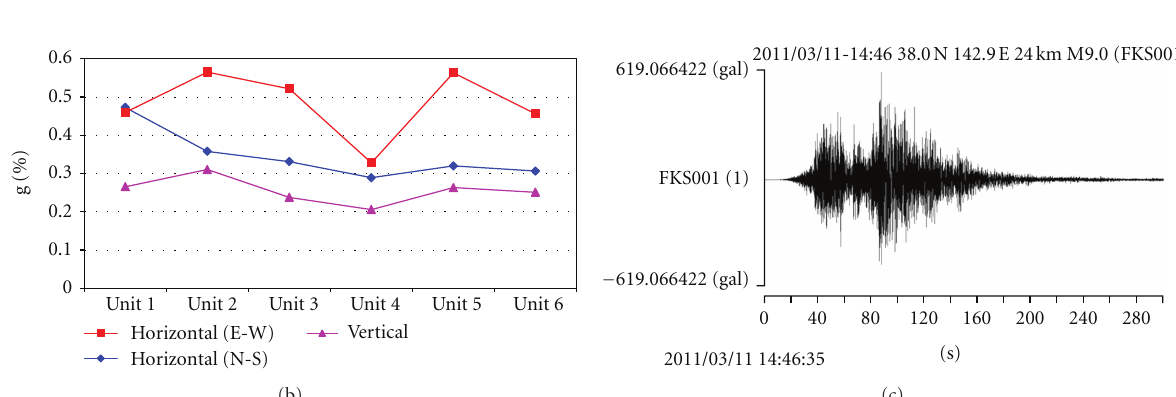
Figure 2: Earthquake: (a) geographical view of the earthquake and tsunami a ff ected area in the North-East region of Japan, including localization of NPP in the Country; (b) maximum acceleration values measured at the Fukushima site; (c) typical measured acceleration time trend at the Fukushima